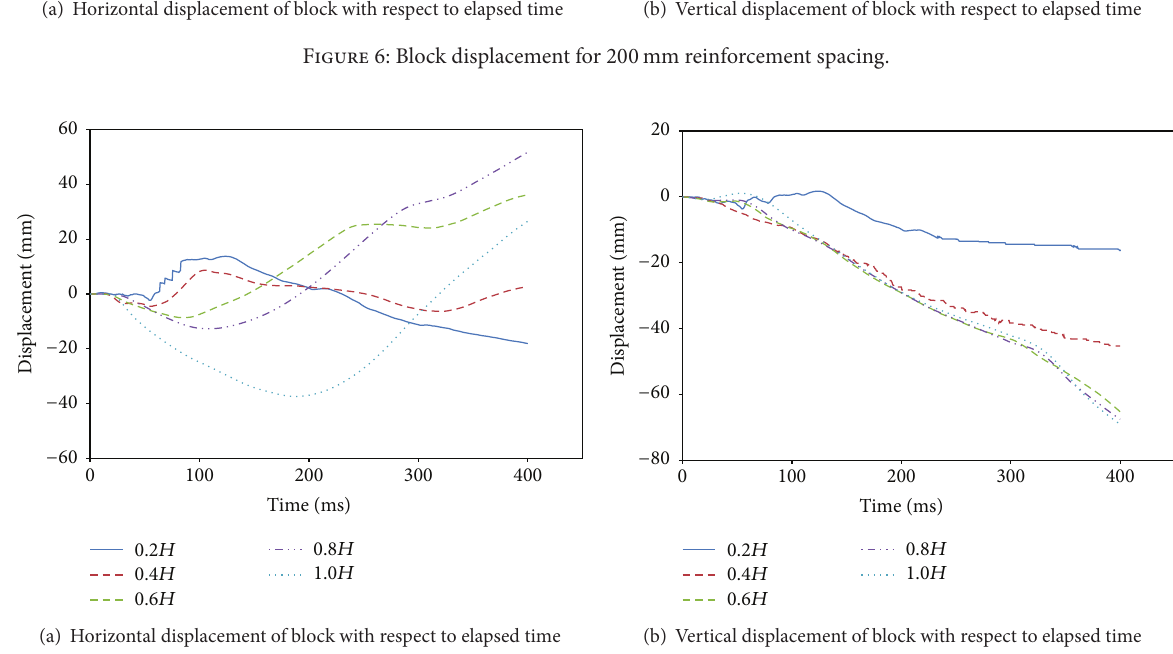
Figure 7: Block displacement for 400 mm reinforcement